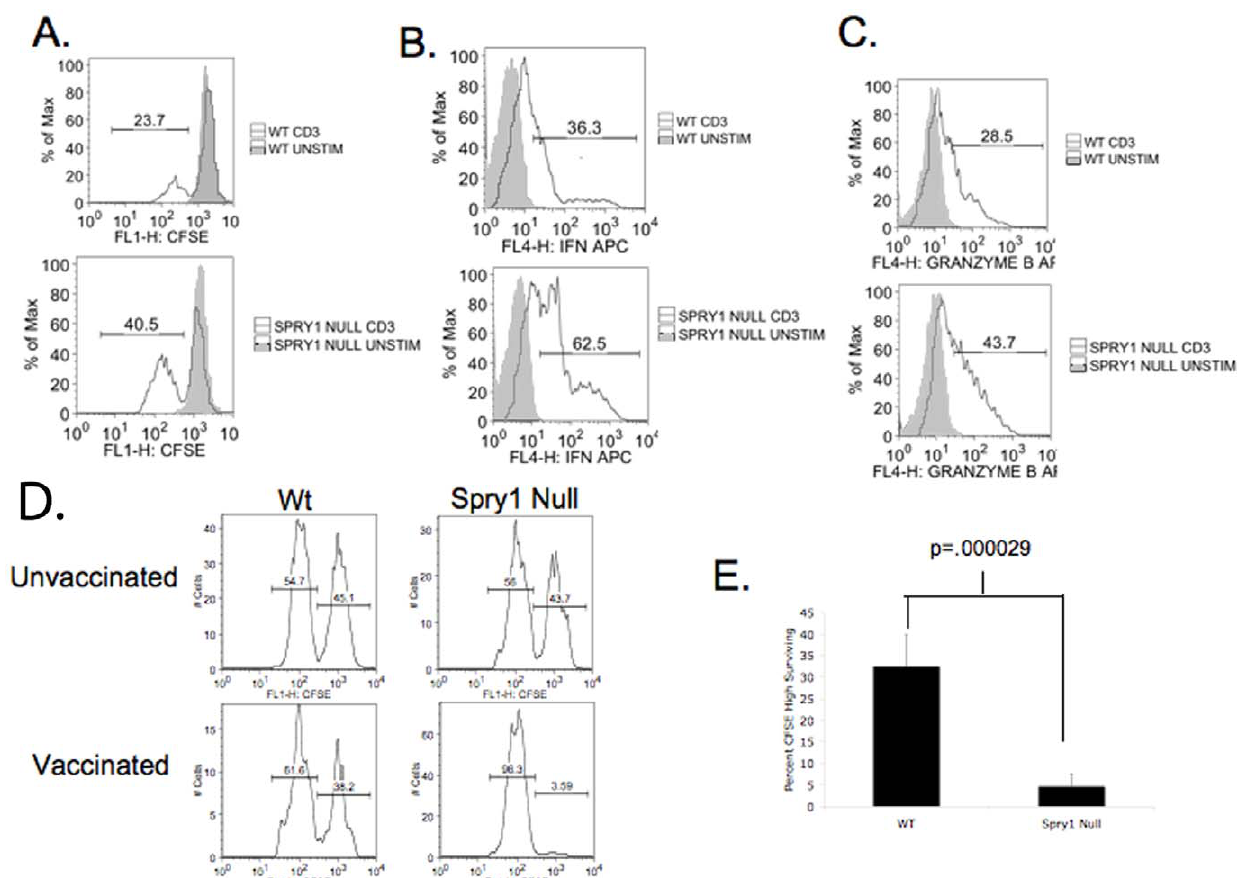
Figure 4. Spry1 null CD8 + T cells have enhanced effector function. Spry1 null and wild type spleens were expanded in vitro with anti-CD3, spleens were rechallenged with anti-CD3. A. CFSE dilution of wild type and Spry1 null CD8 + T cells. Intracellular cytokine secretion assay was performed for IFN c ( B ) and Granzyme-B ( C ). A mixture of CFSE high labeled, peptide pulsed splenocytes and CFSE low unlabeled splenocytes were injected I. V. into either wild type or Spry1 Flox/Flox Lck Cre mice. Sixteen hours later splenocytes were analyzed by flow cytometry for the presence of CFSE high and CFSE low cells. D. Representative histogram data (for individual mice) from unvaccinated and vaccinated Wt and Spry1 Flox/Flox Lck Cre mice. Percentages are representative of CFSE high and CFSE low populations. E. Graphical representation of data from five wild type and five Spry1 Flox/Flox Lck Cre mice. Error bars represent one standard deviation of the mean. P values indicate statistical significance by student t-test. All experiments were performed at least three